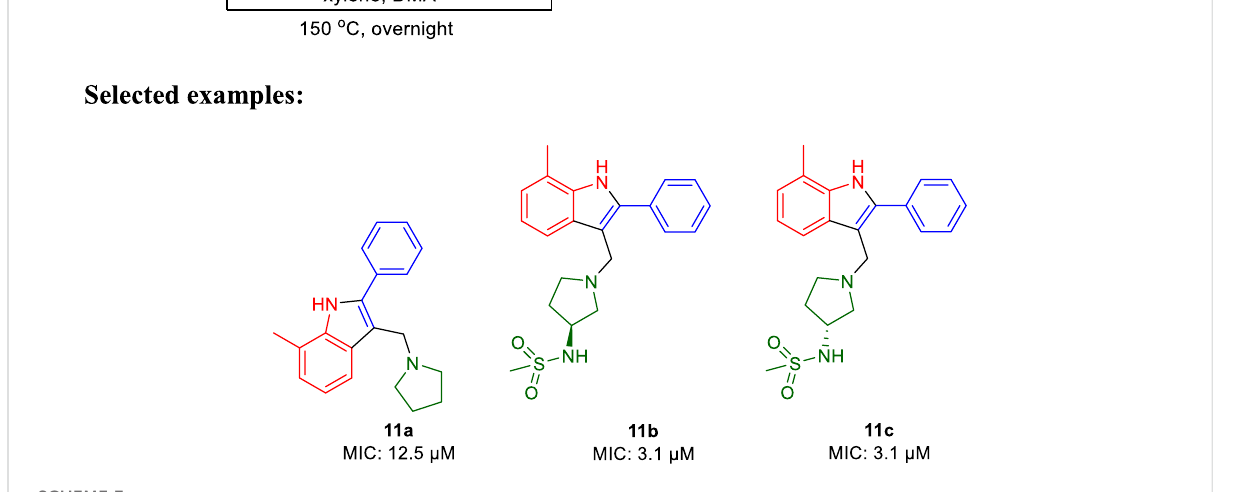
SCHEME 3 Microwave-assisted synthesis of